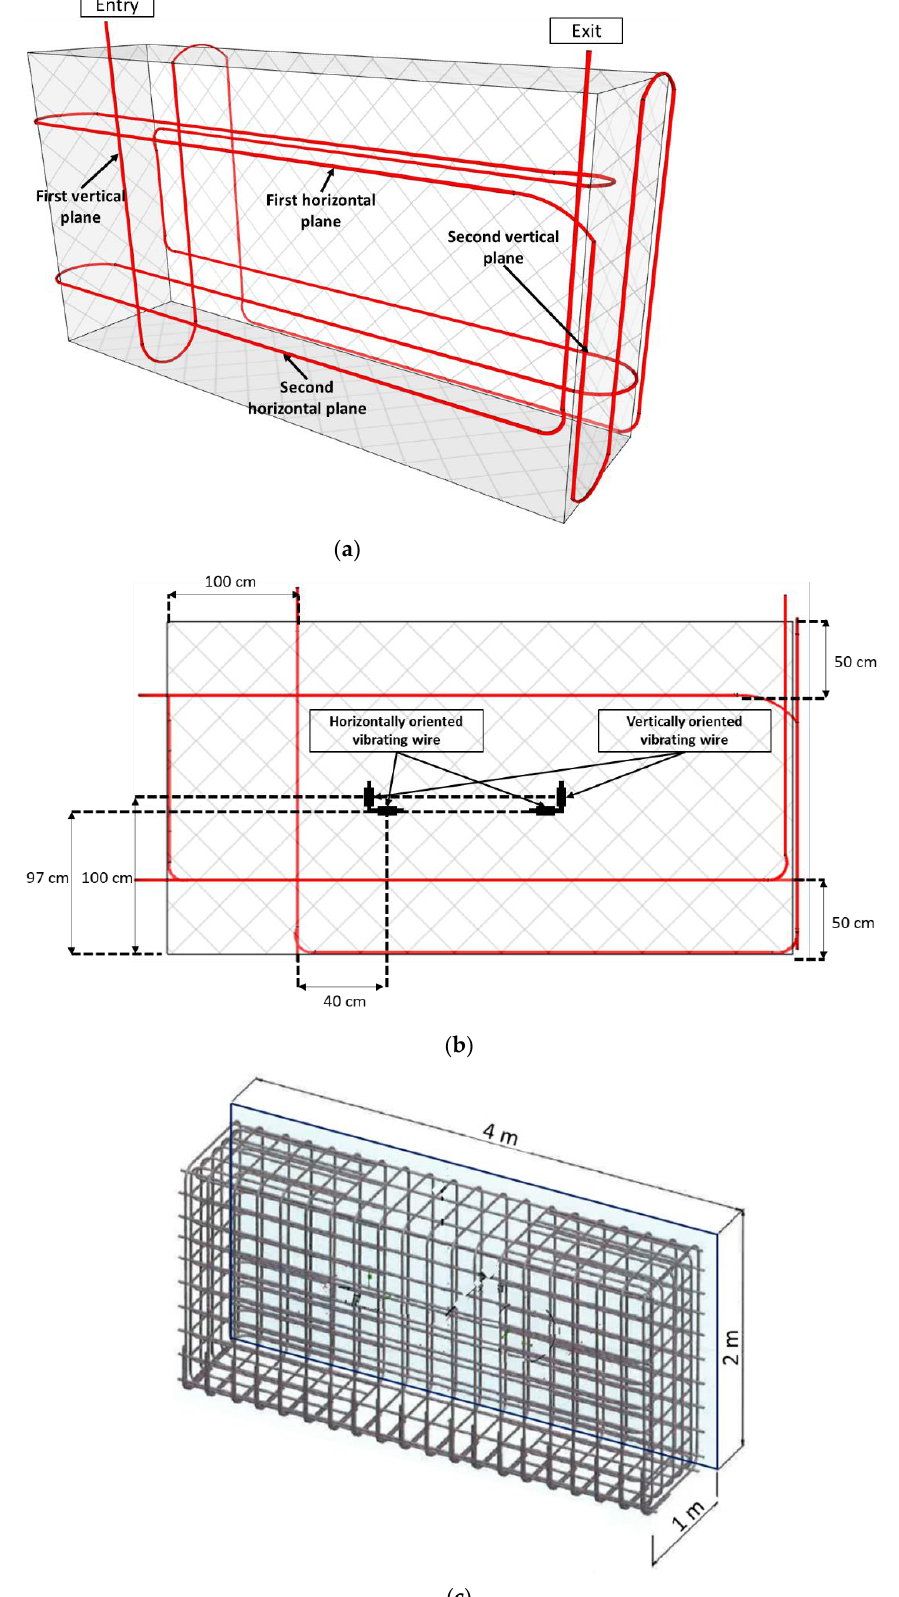
Figure 8. ( a ) Instrumentation scheme of RC blocks with embedded DOFS; ( b ) Projection view show- ing the horizontal/vertical positions of the embedded DOFS and vibrating wire sensors; ( c ) detail of the steel stirrup in RC blocks.